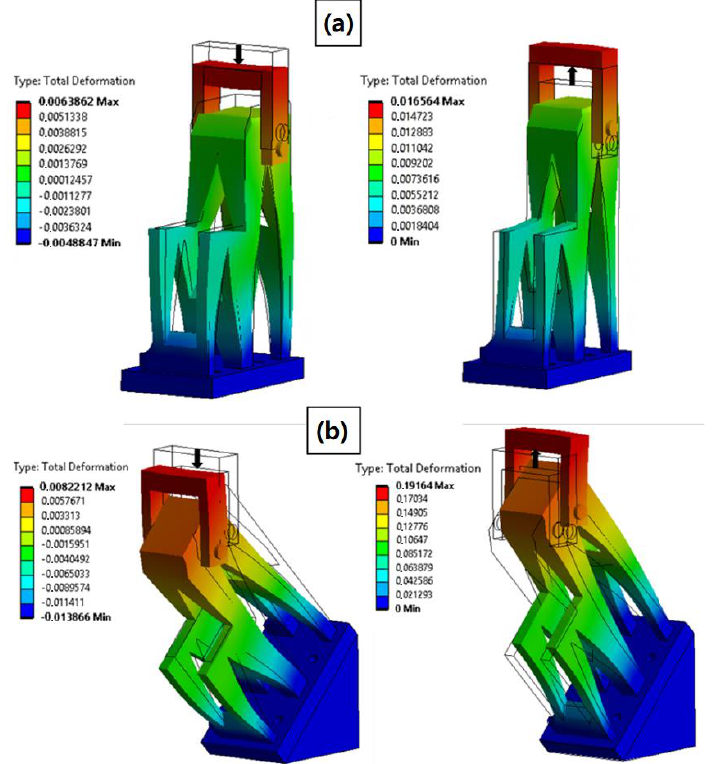
Figure 9. FEM simulation of the turret. Deformation analysis at ( a ) 0° and ( b ) 45° for WAAM AA5356.